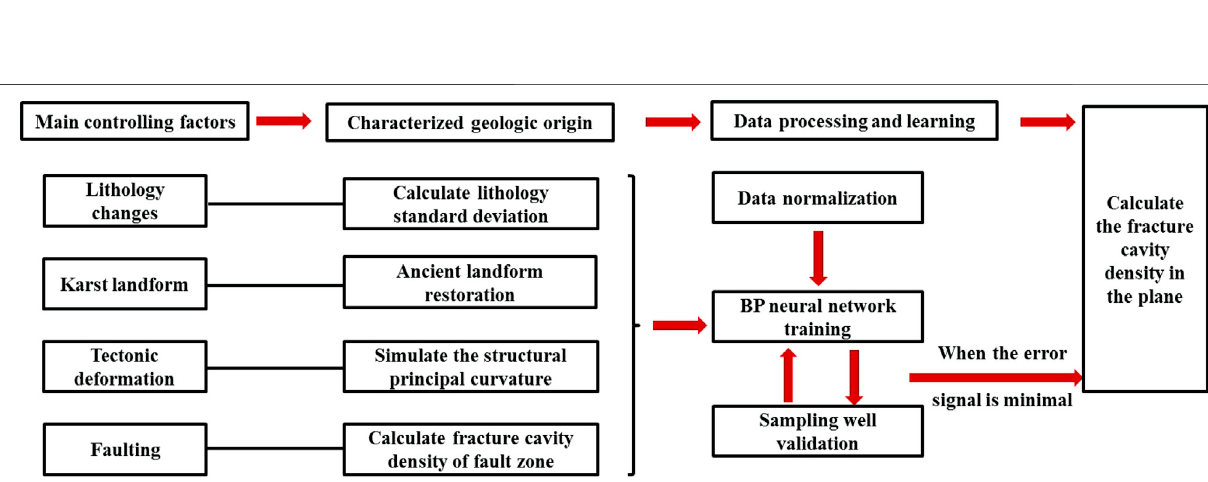
Frontiers in Earth Science |